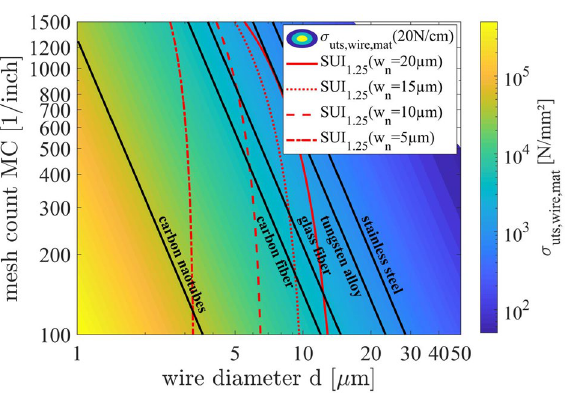
Figure 7. The simulation of the ultimate tensile strength σ uts_wire of individual wires. The mesh parameters are varied between 100–1500 1/inch for the mesh count MC and 1–50 µm for the wire diameter d. A fixed screen tension of 20 N/cm was used. Furthermore, constant lines for certain materials are shown and discussed (e.g. stainless steel, tungsten, glass fibers, carbon fibers, carbon nanotubes). Finally, constant SUI lines are given for different desired screen opening channels w